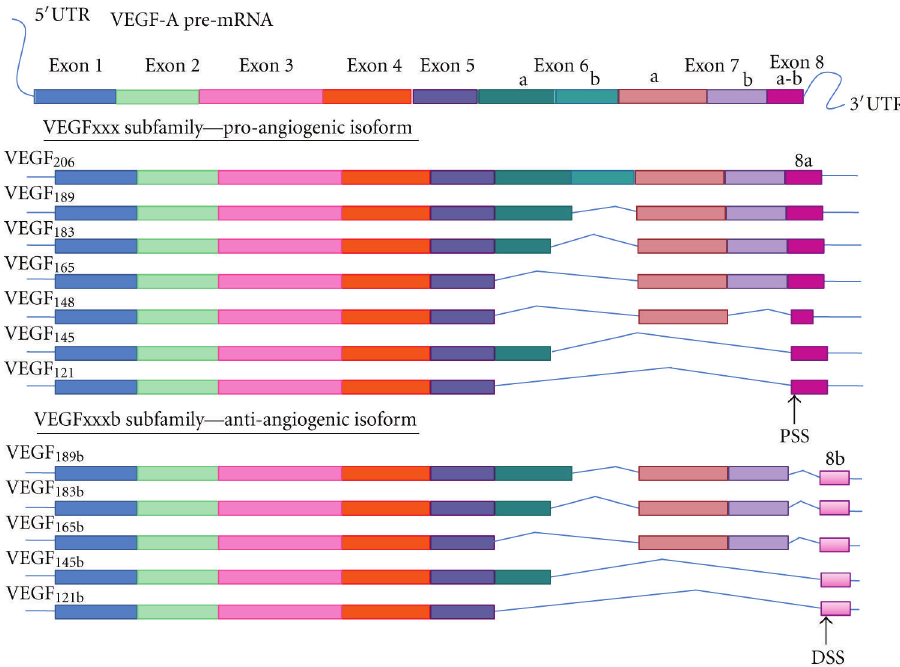
Figure 1: Alternative splicing of VEGF-A pre-mRNA. The pre-mRNA of VEGF-A undergoes alternative splicing leading to pro-angiogenic isoforms notated with the number of amino acids and containing as last exon, the exon 8a stemming from the Proximal Splicing Site (PSS) located at the beginning of exon 8. The more recent subfamily of VEGF isoforms containing five members so far, are anti-angiogenic and contain as last exon, the exon 8b resulting of the splicing at the Distal Splicing Site (DSS) located after the exon 8a.